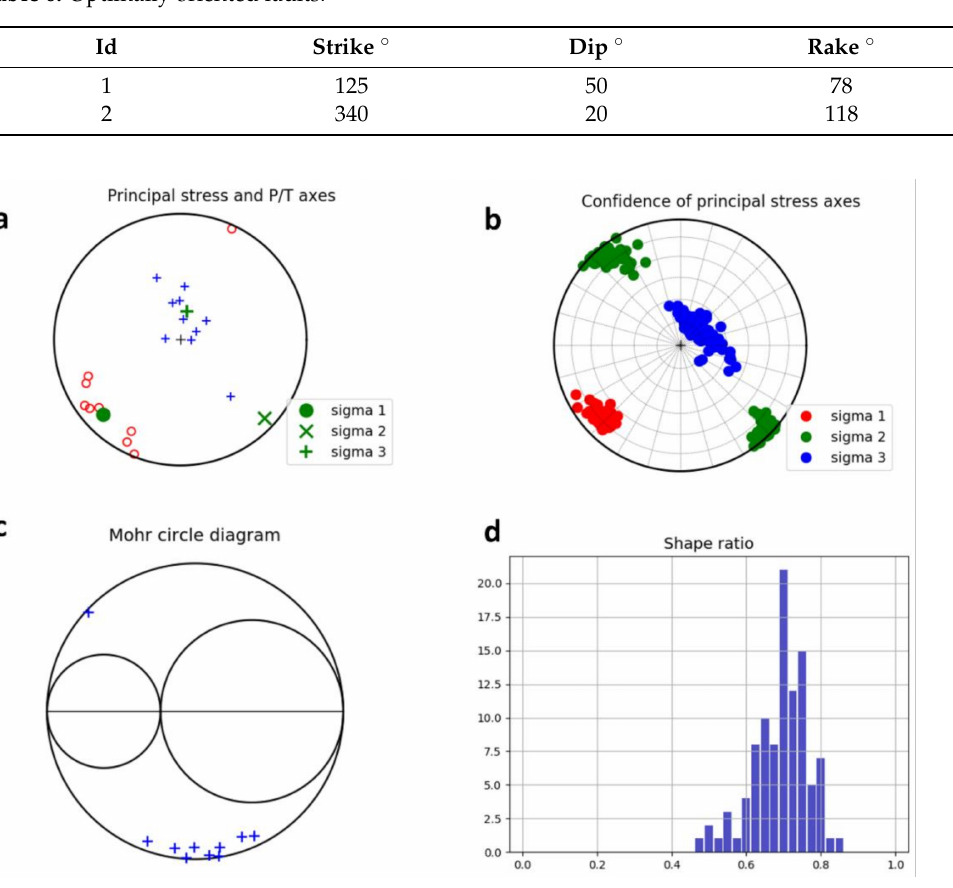
Figure 9. Stress inversion analysis results based on the seismic waveform focal mechanisms of the sequence. ( a ) Principal stress diagram. The stresses indicate a clear thrust faulting. ( b ) Uncertainty of the principal stresses, ( c ) Mohr’s cycle diagram with the positions of the faults (blue crosses). All events, except one, are in the lower semi-circle, which represents the second optimally oriented fault with Strike/Dip/Rake = 340 ◦ /20 ◦ /118 ◦ (Table 6). ( d ) Shape ratio